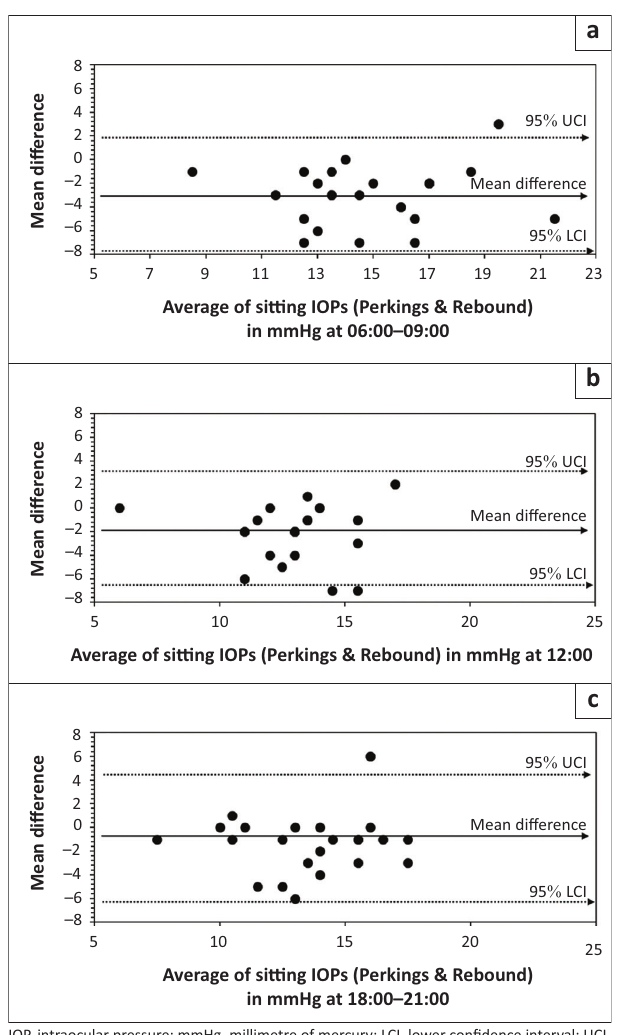
FIGURE 2: Intraocular pressure variations with participants in the sitting position. The Bland and Altman plot of agreement in intraocular pressure from rebound tonometer and Perkins applanation tonometer in the sitting position at different times: (a) 06:00–09:00, (b) 12:00–15:00 and (c) 18:00–21:00. The solid line represents the mean difference, whereas the dotted lines represent the upper and lower limits of